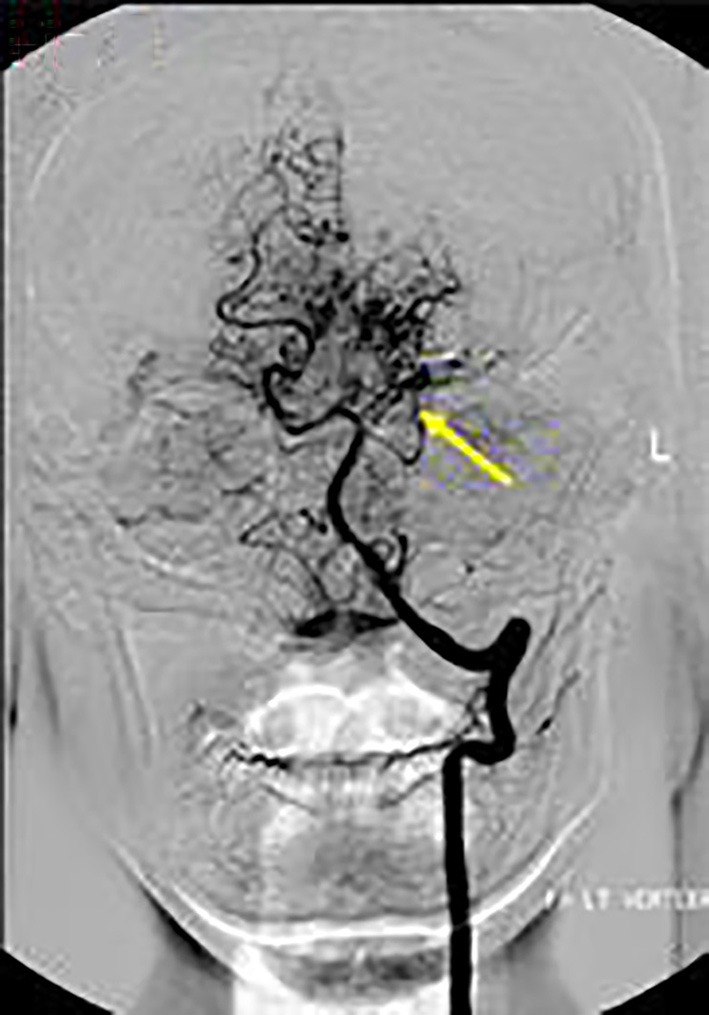
AP views following left vertebral artery injection showed moyamoya phenomenon around the proximal left PCA (arrow).